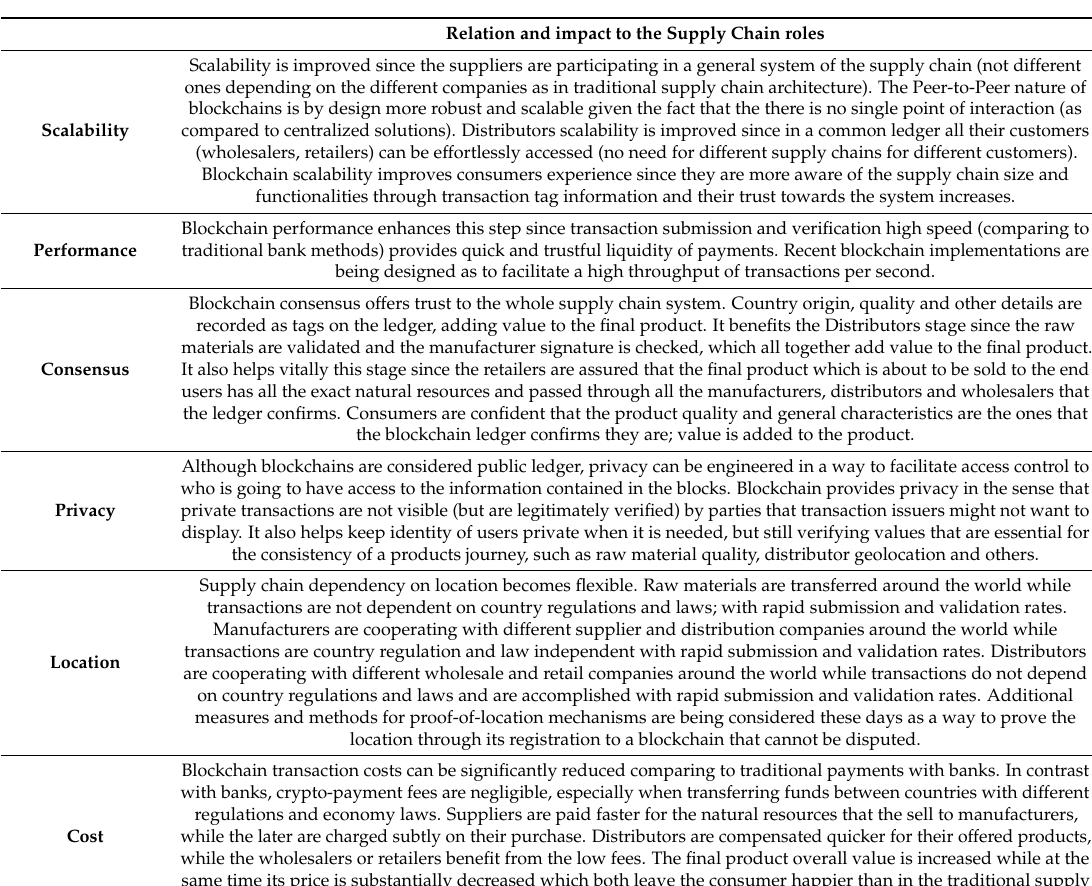
Table 2. Blockchain Elements that affect Supply Chain Logistics with Roles